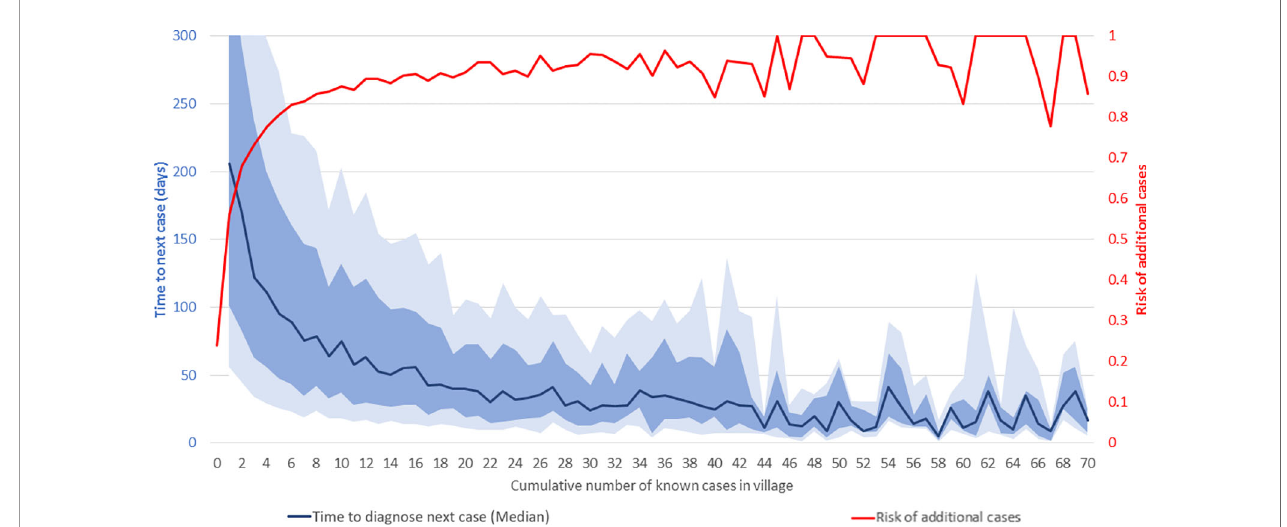
FIGURE 3 | Time-to-next-case and risk of additional visceral leishmaniasis (VL) cases in affected villages. The horizontal axis shows the cumulative number of known VL cases at the village-level from January 2013 to September 2020. The red line shows the risk of additional VL cases (scale on right-hand vertical axis). The dark blue line shows the median interval in days to the next VL diagnosis in the village (scale on left-hand vertical axis). The light and medium blue shading indicates the ranges from the 25 th to 75 th percentiles and 35 th to 65 th percentiles, respectively. The horizontal axis is truncated at 70 cases and the left-hand vertical axis at 300